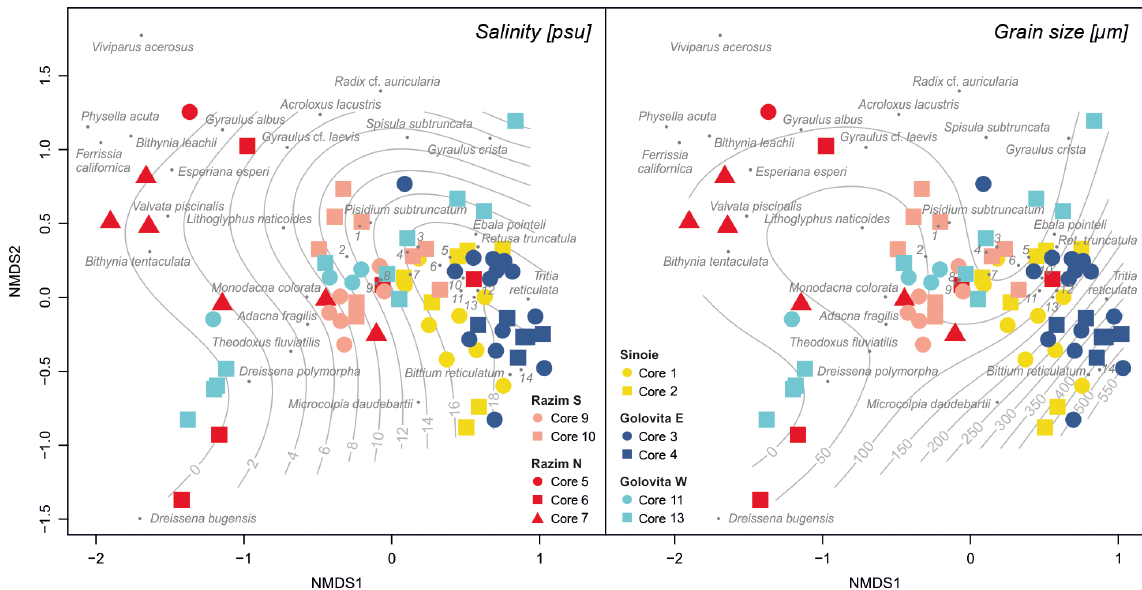
Figure 5. NMDS ordination plot of species compositions across samples grouped into lake regions (stress = 0 . 173). Optimum salinity and grain size were fitted as two-dimensional smooth surfaces to illustrate the associations with species composition. Species are marked with numbers: 1 – Planorbis planorbis , 2 – Clathrocaspia knipowitschii , 3 – Potamopyrgus antipodarum , 4 – Theodoxus danubialis , 5 –